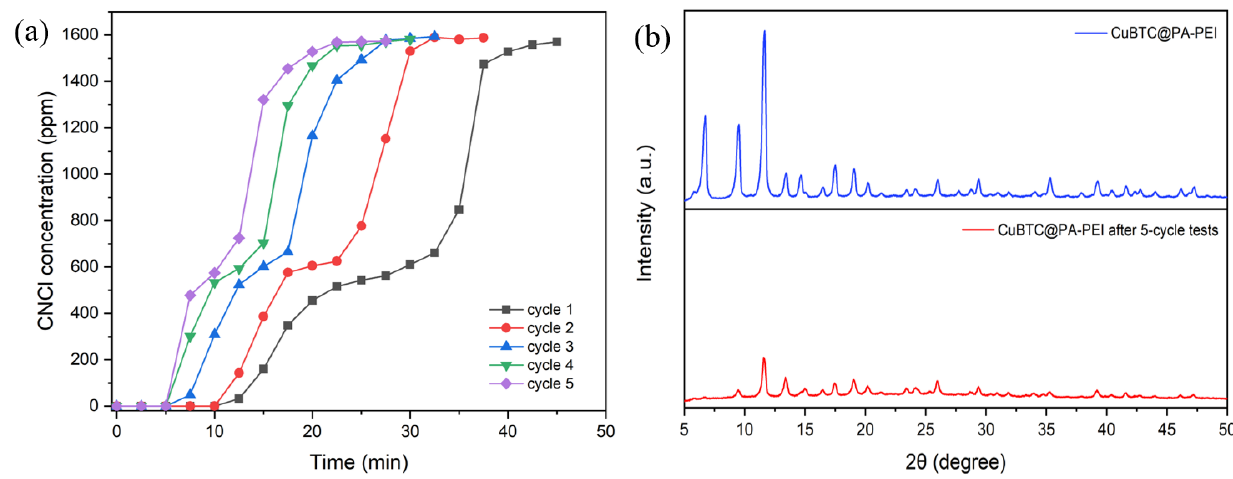
Figure 8. ( a ) CNCl breakthrough curves of CuBTC@PA-PEI for different adsorption-desorption cycle times; ( b ) XRD patterns of CuBTC@PA-PEI before and after 5 cycles of adsorption-desorption.